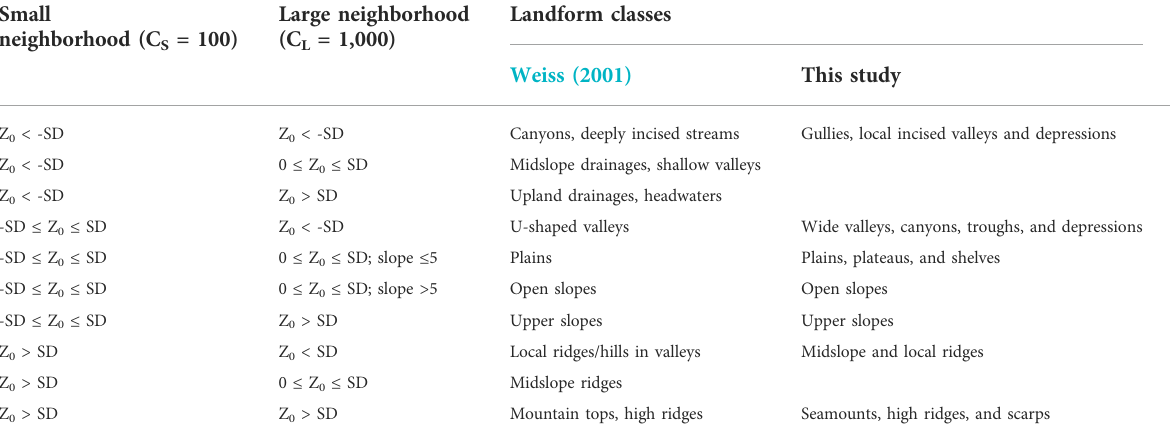
TABLE 2 Landform classi fi cation based on TPI values.